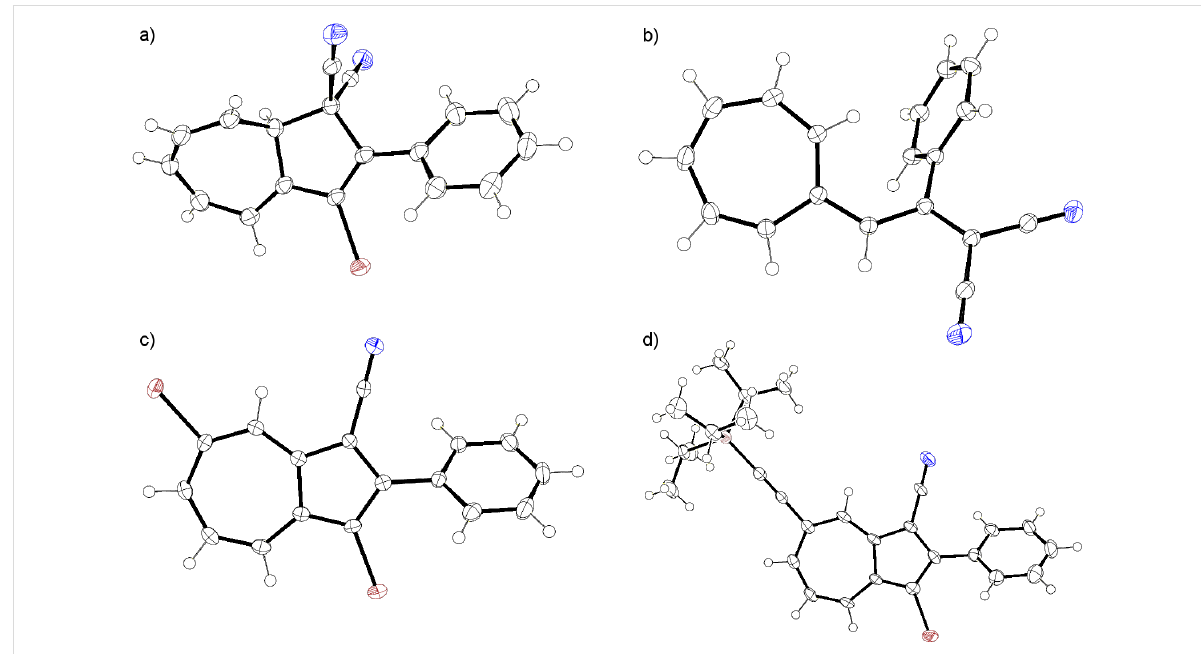
Figure 3: Molecular structures (with displacements ellipsoids at 50% probability for non-H atoms) of (a) DHA 8 (CCDC 868717; crystals were grown from butanone/heptane); (b) VHF 2 (CCDC 866016; crystals were grown from benzene/cyclohexane; benzene cocrystallized with the VHF but has been omitted for clarity); (c) azulene 14 (CCDC 868718; crystals were grown from dichloromethane/heptane); (d) azulene 15 (CCDC 868719; crystals were grown from dichloromethane/heptane).